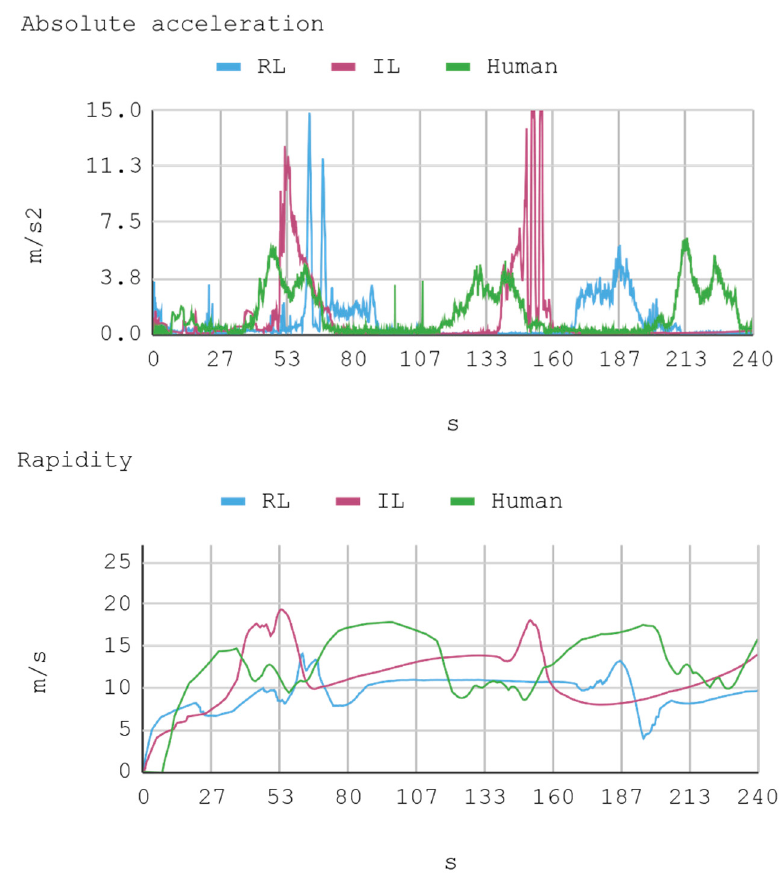
Figure 10. Case 1. Automobile’s absolute acceleration and rapidity.